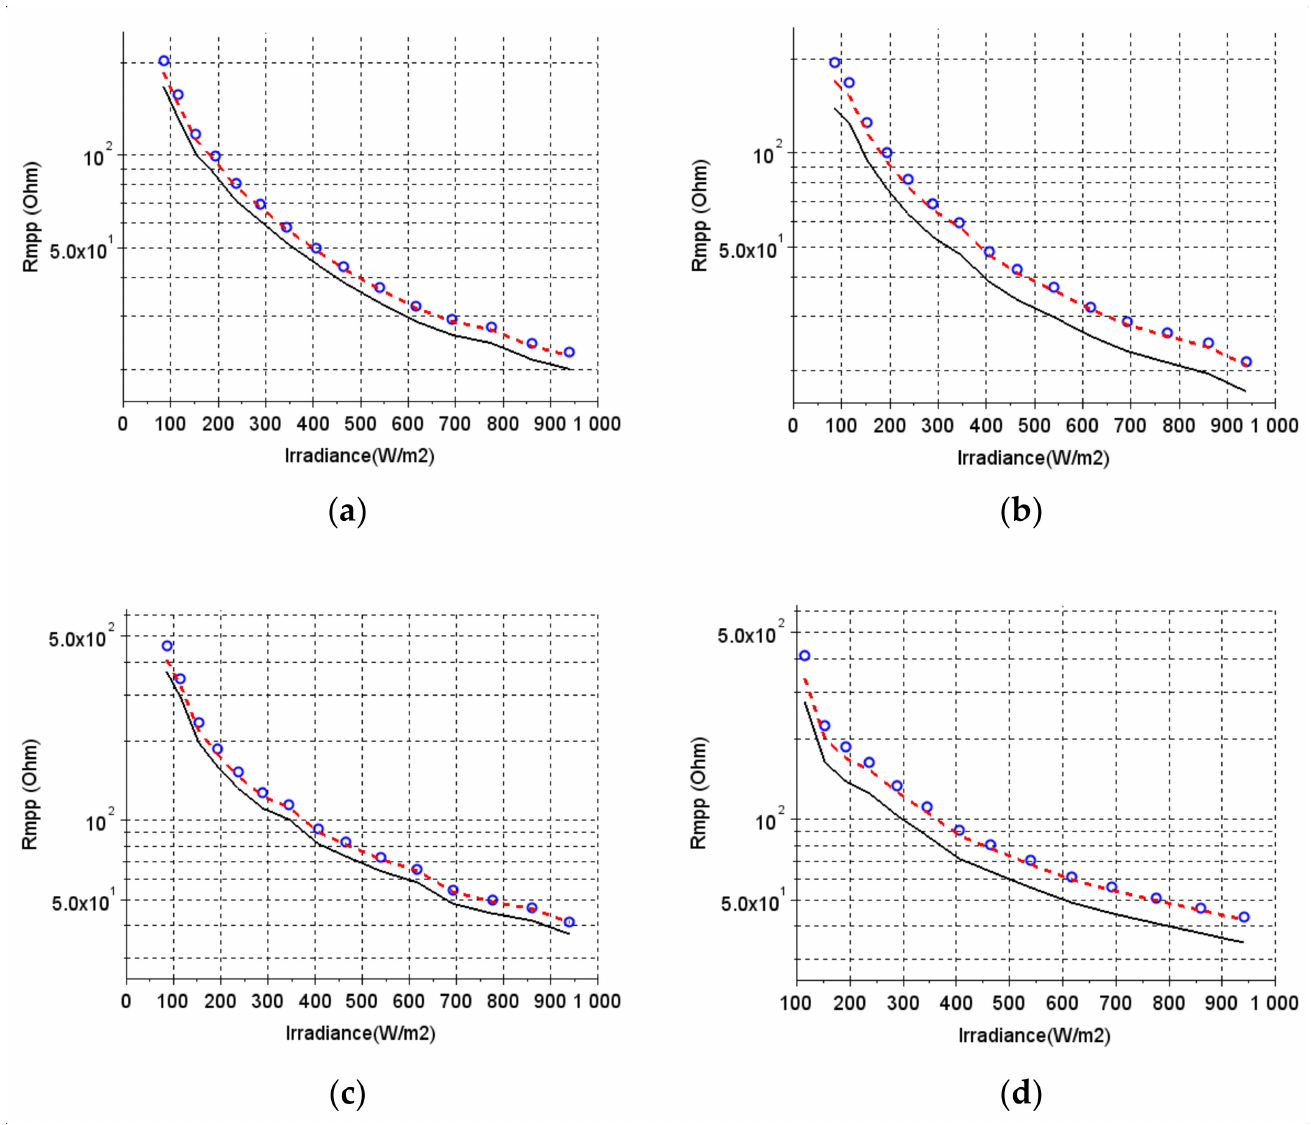
Figure 8. Input resistance of a buck converter at the maximum power point for different irradiance levels: ( a ) PV 10 W, R LOAD = 10 Ω ; ( b ) PV 10 W, R LOAD = 5 Ω ; ( c ) PV 5 W, R LOAD = 10 Ω ; and ( d ) PV 5 W, R LOAD = 5 Ω . The solid line is the ideal model, the dashed lines are the model with parasitic resistances, and the dots represent the experimental data